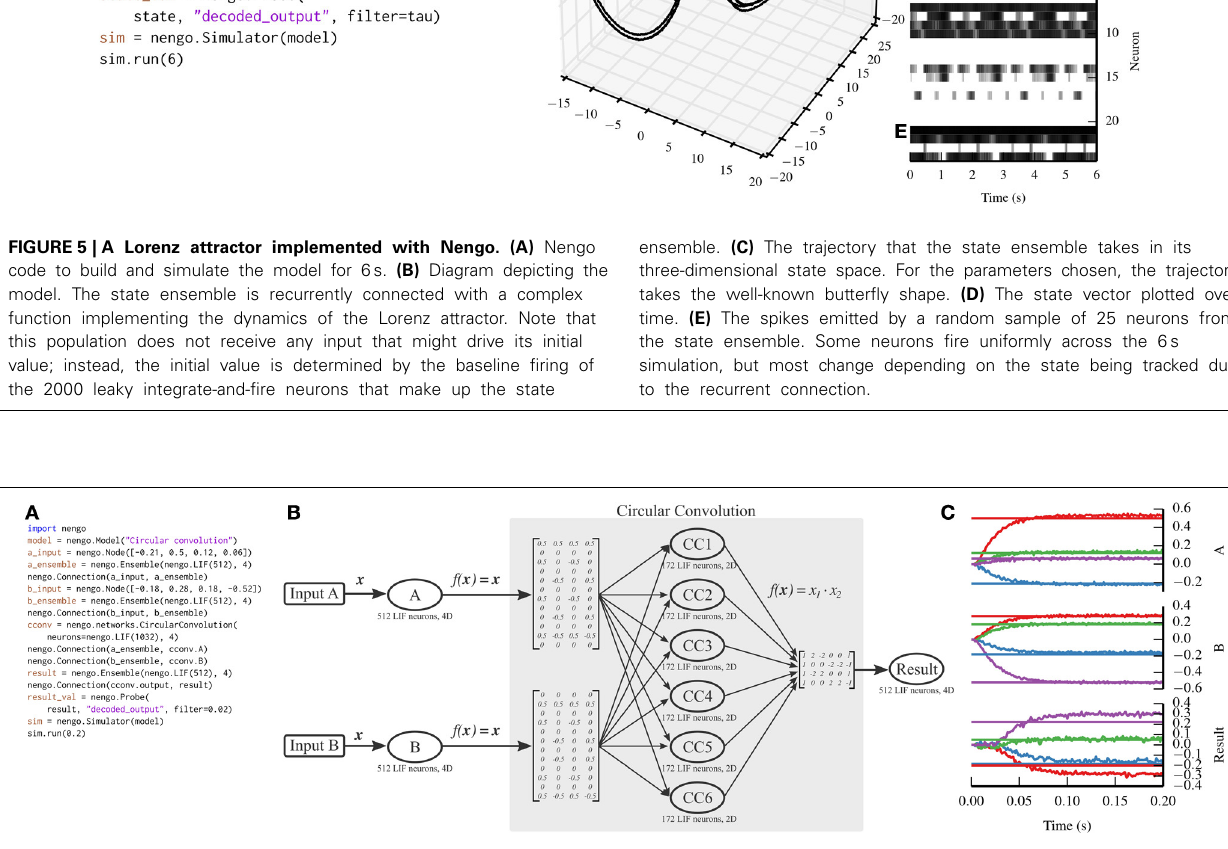
FIGURE 6 | Circular convolution implemented with Nengo. (A) Nengo code to build and simulate the model for 0.2s. (B) Diagram depicting the model. The input vectors, A and B, represent four-dimensional vectors which are mapped onto six ensembles within the circular convolution network through complicated transformation matrices that implement a discrete Fourier transform. Each ensemble within the network represents a two-dimensional vector. The product of the two dimensions is projected through another complicated transformation matrix that implements the inverse discrete Fourier transform, computing the final four-dimensional